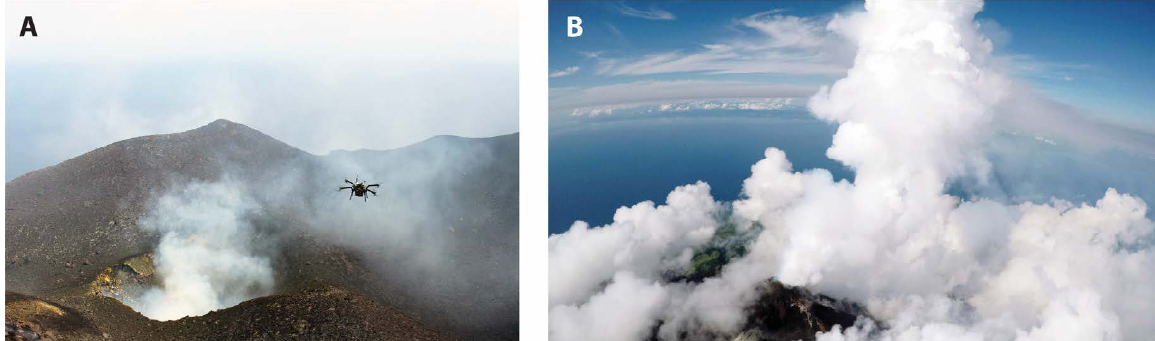
Figure 15: Aerial gas measurements using drone-mounted Multi-GAS analyser. [A] Short-range but long time- series measurements using multi-rotor platform at Stromboli, Italy, in June 2017, and [B] long-range but short time-series measurements using fixed-wing platforms at Manam, Papua New Guinea, May 2019.